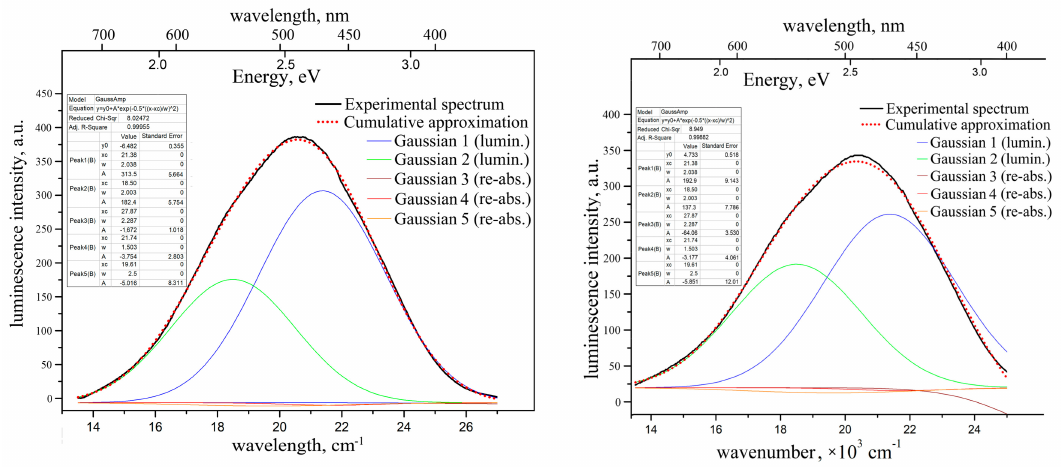
Figure 7. Unpolarized photoluminescence spectra of “pure” ZnWO 4 crystal ( left ) and of the crystal- etalon ( right ), and their decomposition onto the elementary Gaussians. λ ex = 312 nm, T = 300